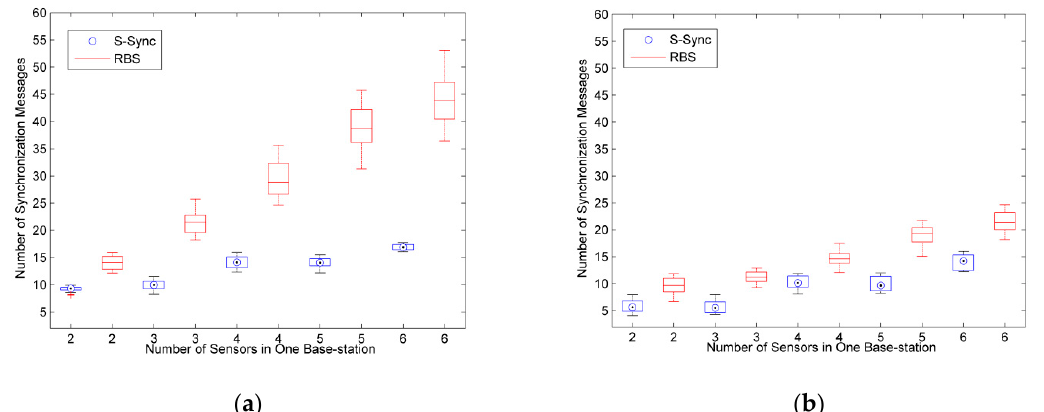
Figure 10. Comparative analysis of energy consumption for base-station to base-station synchronization. ( a ) ξ ≤ 1 (ms); ( b ) 1 < ξ ≤ 2 (ms).